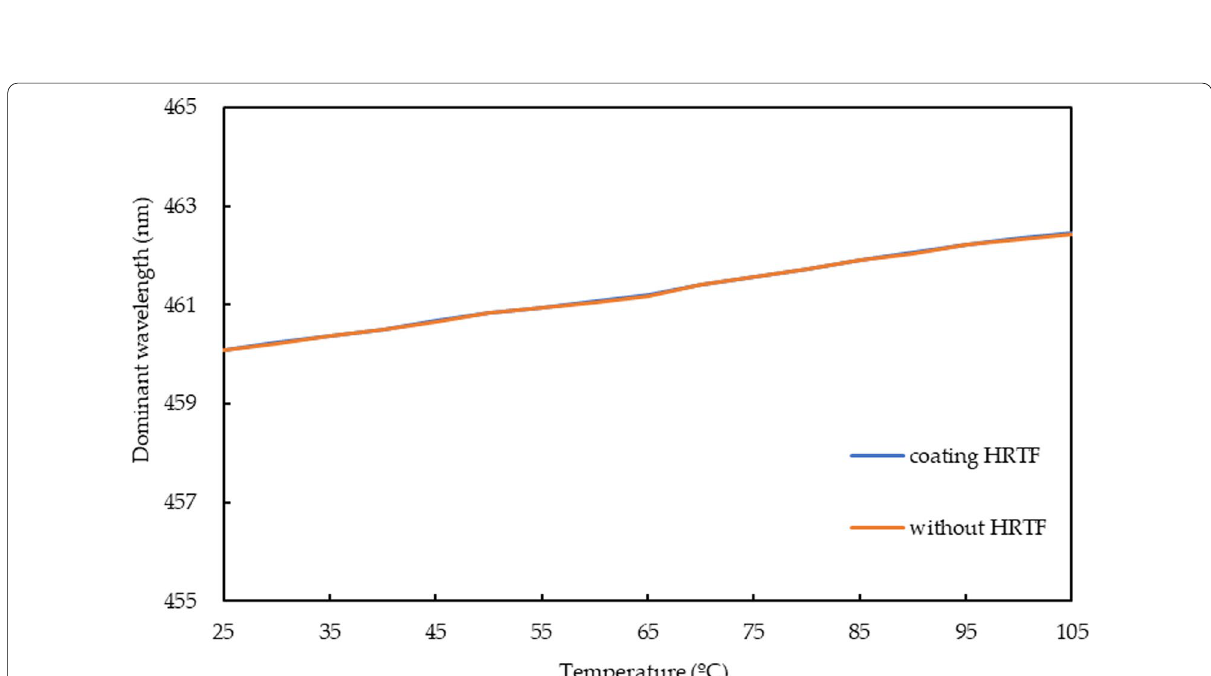
Fig. 11 Characteristic curves of the peak wavelengths for micro‑LEDs with and without Al/(HL) 2 film stack coatings based on temperature